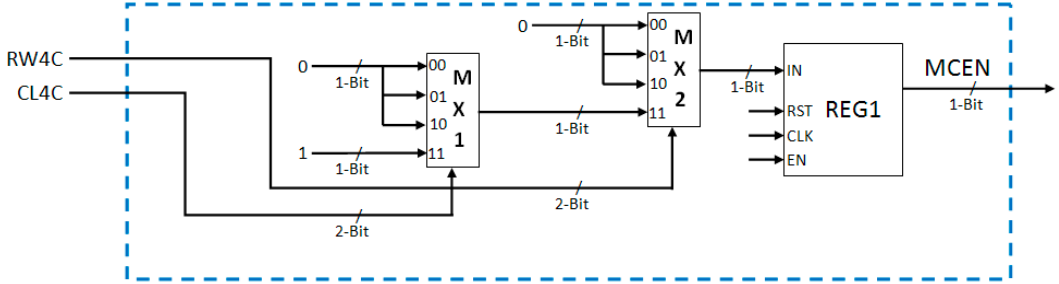
Figure 10. VLSI architecture of motion computation enable signal generation unit.